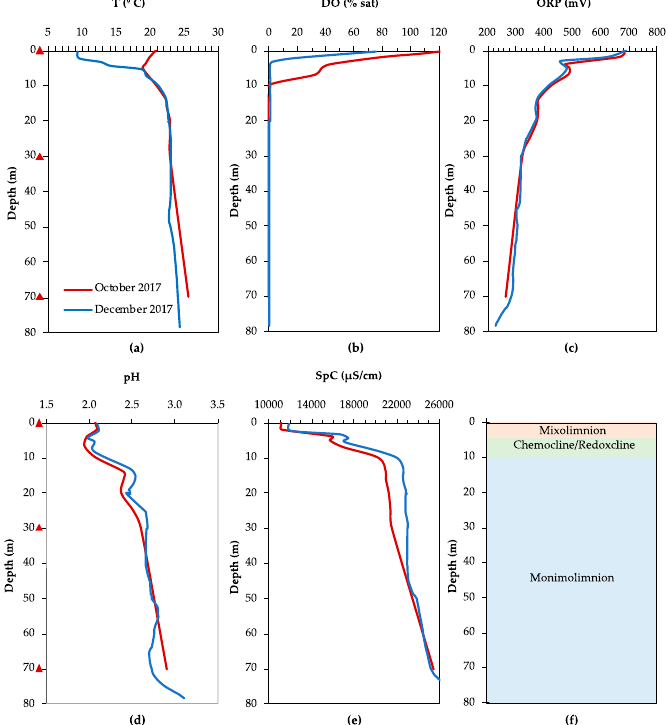
Figure 5. Physicochemical profiles of the water column in La Zarza. ( a ) Temperature (T), ( b ) dissolved oxygen (DO), ( c ) oxidation–reduction potential (ORP), ( d ) acidity (pH), ( e ) specific conductivity (SpC), and ( f ) inferred chemical zonation of the water column. Triangles indicate the sampling depths for biomass filtration in October 2017. Analysis of the chemical composition of the water column in LZ indicated that several major (Ca, SiO 2 , Cu) and trace (Pb, Th) elements displayed clear reactive behavior, indicating their